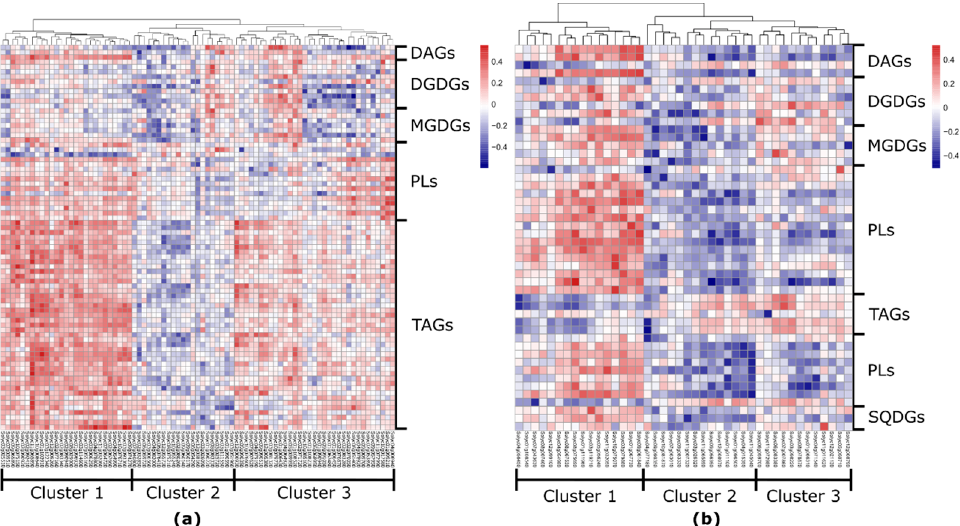
Figure 4. Heatmap of correlation values between lipid-related genes expression and lipid levels in tomato ( a ) fruits and ( b ) leaves. The number of lipid-related genes is higher in the fruit dataset compared to the leaf dataset (81 and 42, respectively). In tomato fruit, lipid-related genes linked mostly to TAGs, while in tomato leaf predominantly to phospho- and galactolipids. DAG—diacylglycerol; TAG—triacylglycerol; DGDG—digalactosyldiacylglycerol; MGDG—monogalactosyldiacylglycerol; SQDG—sulfoquinovosyldiacylglycerol.